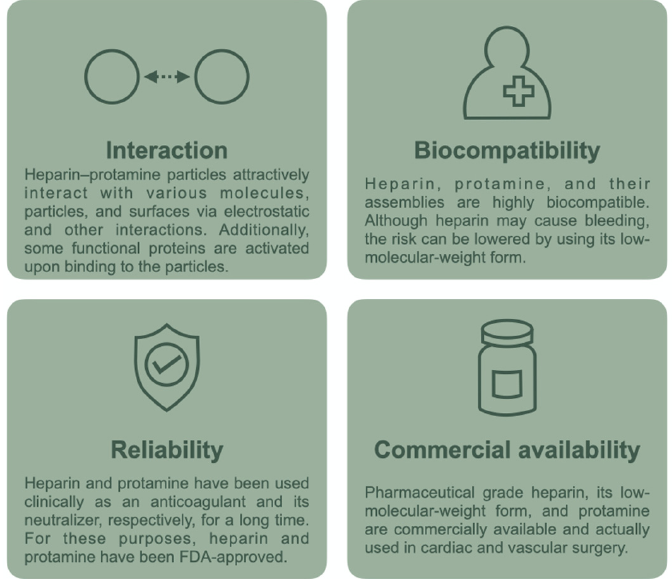
Figure 1. Attractive characteristics of the heparin–protamine system.